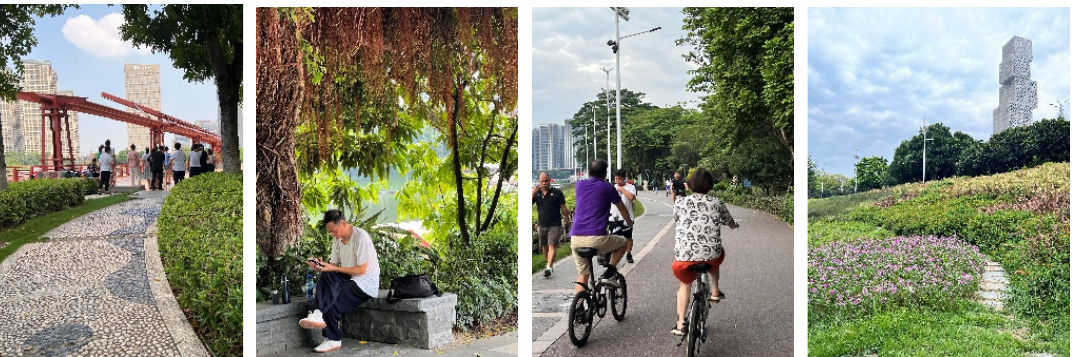
Figure 10. Social stay in the square, leisure stay in the shade, sport stay on the trail, and viewing stay on the flower trail.